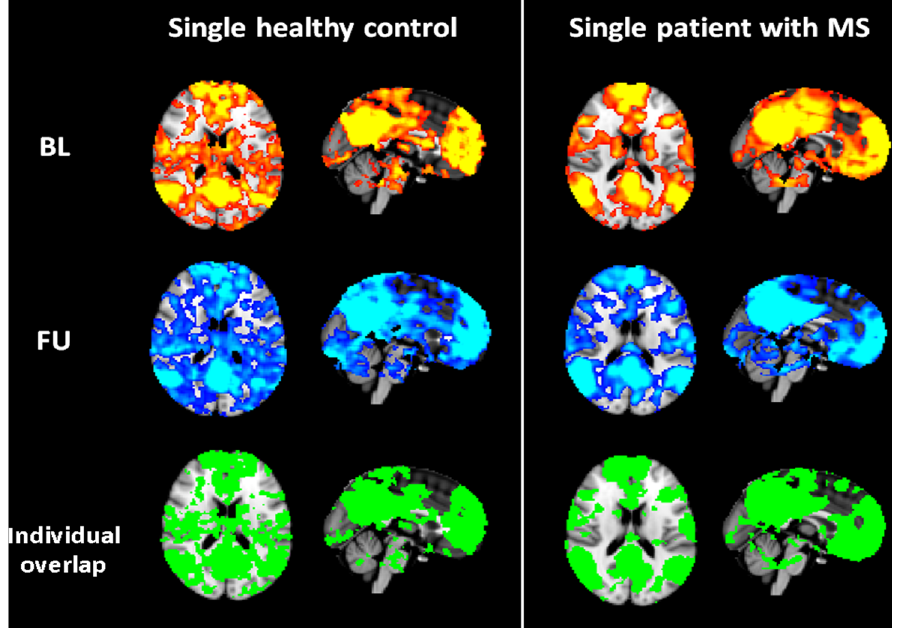
Fig 2. Representative overlapping maps. Representative connectivity maps for baseline (BL), follow-up (FU) and overlap of Z-thresholded (Z > 0) connectivity maps for the DMN (X = 45, Y = 54, Z = 45) for a single healthy control and a single patient with